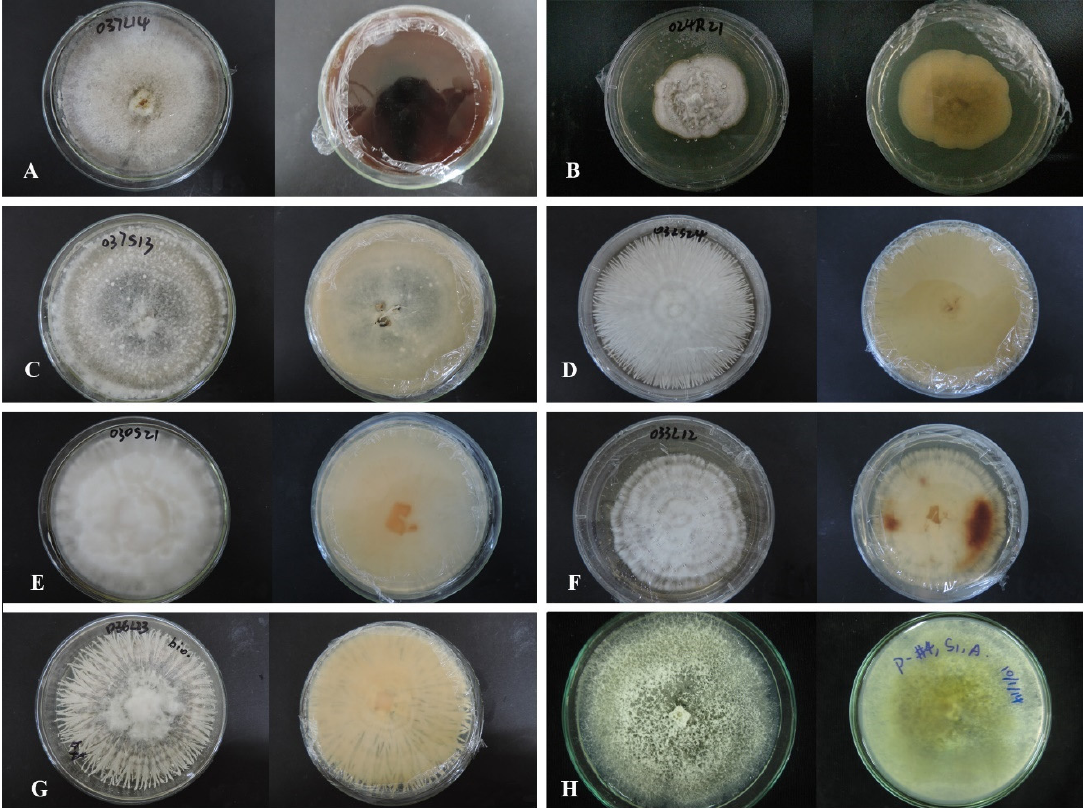
Figure 9. Front and reverse views of the isolates on PDA, isolated Dendrobium species; ( A ) Hypoxylon Front and reverse views of the isolates on PDA, isolated Dendrobium pulicicidum (GZAC O37L14). ( B ) Induratia sp. (MFLUCC 15-1218). ( C ) Nigrospora sphaerica (GZAC species; ( A ) Hypoxylon pulicicidum (GZAC O37S13). ( D ) Xylaria papulis (GZAC O32S24). ( E ) Xylaria feejeensis (GZACA O30S21). ( F ) Xylaria laevis (GZACA O33L12). ( G ) Xylaria curta (GZAC O36L23). ( H ) Xylaria berteri (MFLUCC 14-0142).